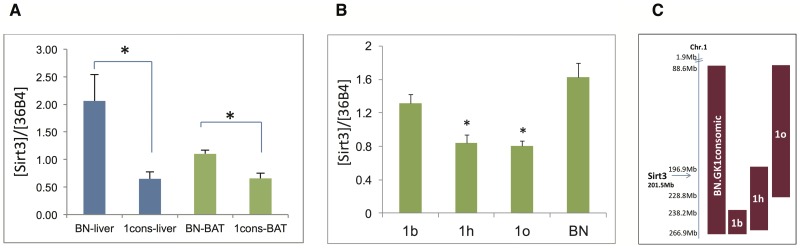
Validation of Sirt3 transcript levels.QRT-PCR of Sirt3 levels (A) comparing BN control rat and congenic strain 1consomic (which has GK chromosome 1 on a BN genetic background), in liver (blue) and BAT (green); (B) left, comparing BAT from BN and three congenic strains, two carrying GK allele of Sirt3 (1o and 1h), and one with BN allele of Sirt3 (1b); (C) diagram of BN.GK chromosome 1 congenic strains used, with maroon bars representing region of GK chromosome 1 introgressed onto BN background. (Genomic location of Sirt3 is indicated.) Results are corrected for expression of housekeeping gene 36B4.